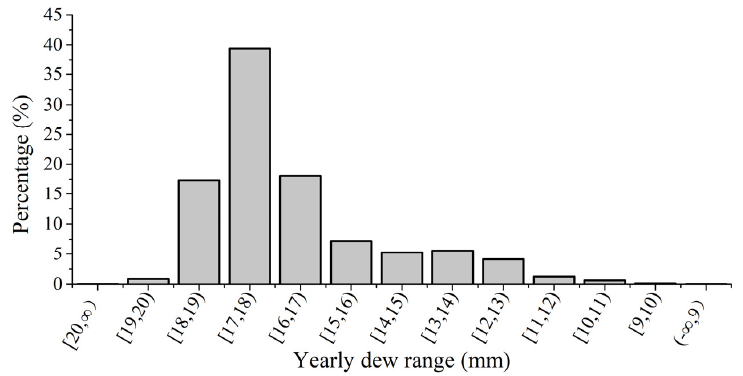
Figure 11. Histogram of the statistical distribution of the annual dew yields in the